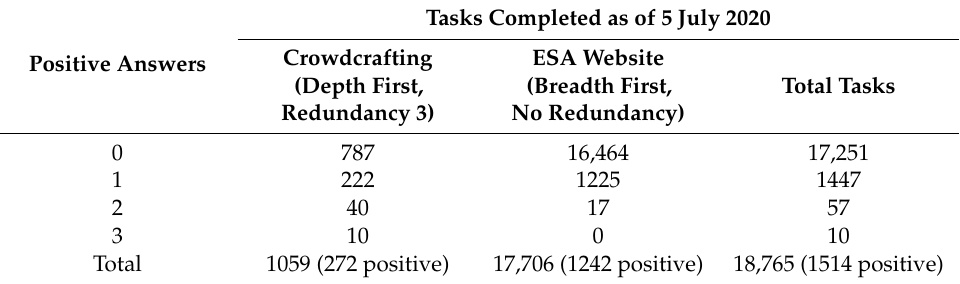
Table 1. Tasks completed as of 5 July 2020. Di ff erent distributions of positive responses are evident according to the two types of priority tasking: depth first and breadth